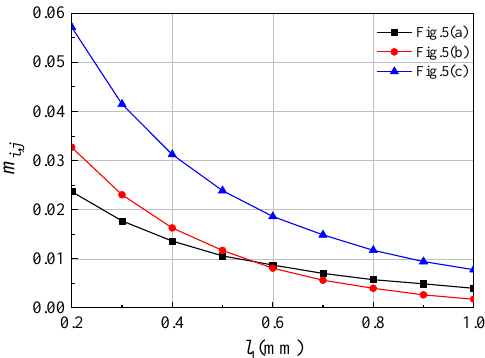
Figure 5. Coupling coefficient between the resonators of type I.